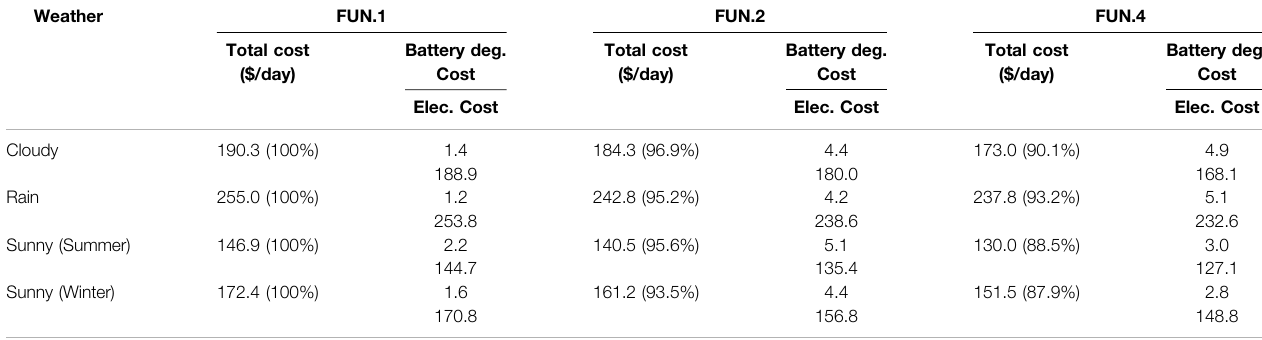
TABLE 4 | Operation cost of station under different weather conditions. Weather